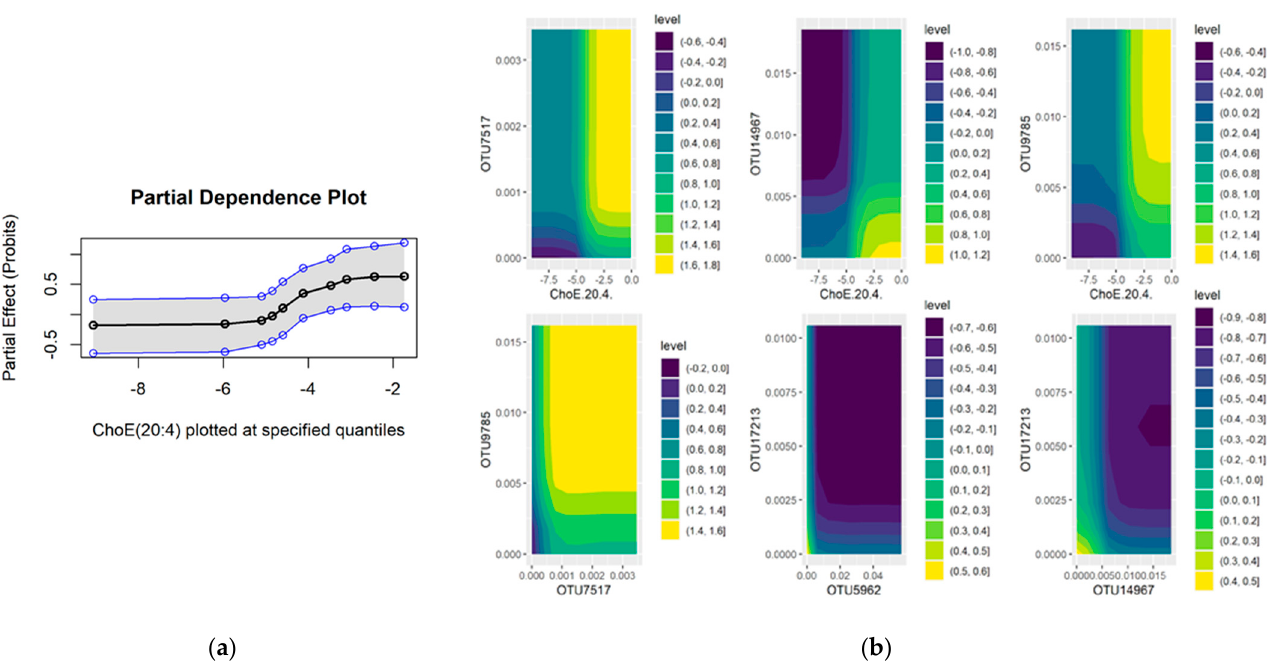
Figure 3. Partial results for Clos-Garcia microbiome and metabolome analysis using BART methods; ( a ) partial dependence plot of ChoE(20:4); ( b ) contour plots for microbiome–metabolome interactions between (1) Staphylococcus (OTU7517) and ChoE(20:4), (2) Blautia (OTU14967) and ChoE(20:4), (3) Roseburia (OTU9785) and ChoE(20:4); microbial interactions between (1) Roseburia (OTU9785) and Staphylococcus (OTU7517), (2) Blautia (OTU5962) and an unknown genus from family Lachnospiraceae (OTU17213), (3) OTU17213 and Blautia (OTU14967). The z -value (level) is the log-odds of CRC, interpreted in the same way as Figure 2.